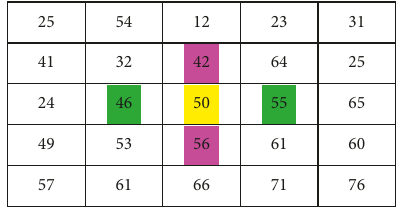
Figure 9: Matrix to compute magnitude and